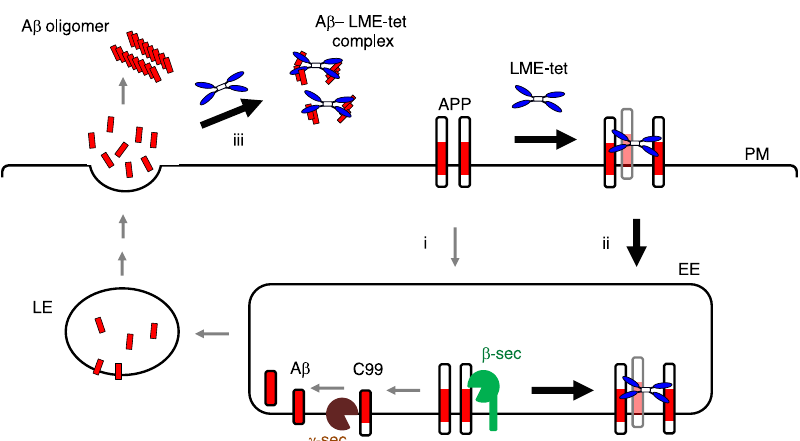
Fig. 7 Model for the proposed molecular mechanism underlying the intracellular and extracellular effects of LME-tet. APP present in the plasma membrane (PM) is internalized into early endosomes (EE) and then into late/recycling endosomes (LE), where A β is produced by sequential proteolysis of APP performed by β -secretase and γ -secretase. A β is released into the extracellular space and then aggregates to from A β oligomers (i, gray arrows). LME- tet binds to APP in the plasma membrane through multivalent interaction. This complex is transported to the endosomes and blocks A β production through speci fi c inhibition of β -cleavage, but not γ -cleavage (ii). In addition, LME-tet suppresses oligomerization of extracellular A β by inhibiting the formation of its β -sheet conformation